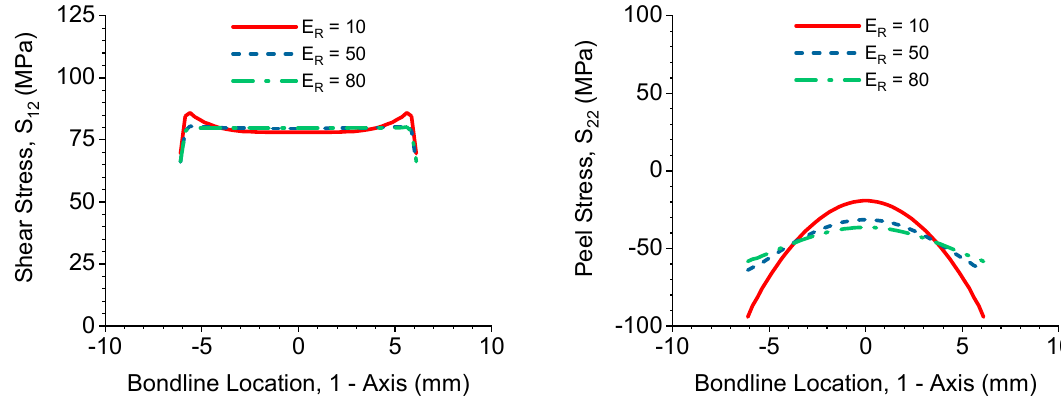
Figure 11. Shear stress and peel stress distributions along the bondline in a block shear geometry for different modulus ratios, E r